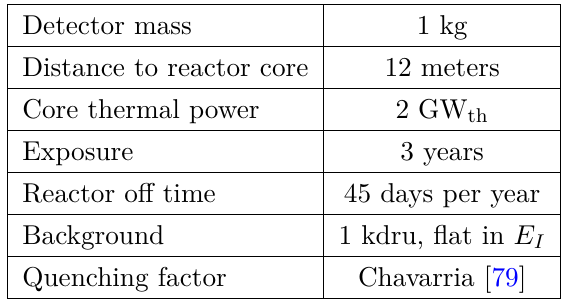
Table 2 . Benchmark experimental setup considered